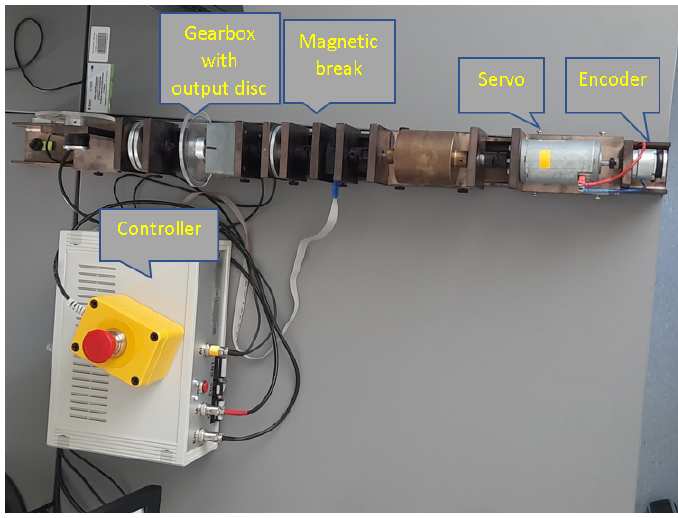
Figure 7. The examined modular sensor-aided servomechanism (source: